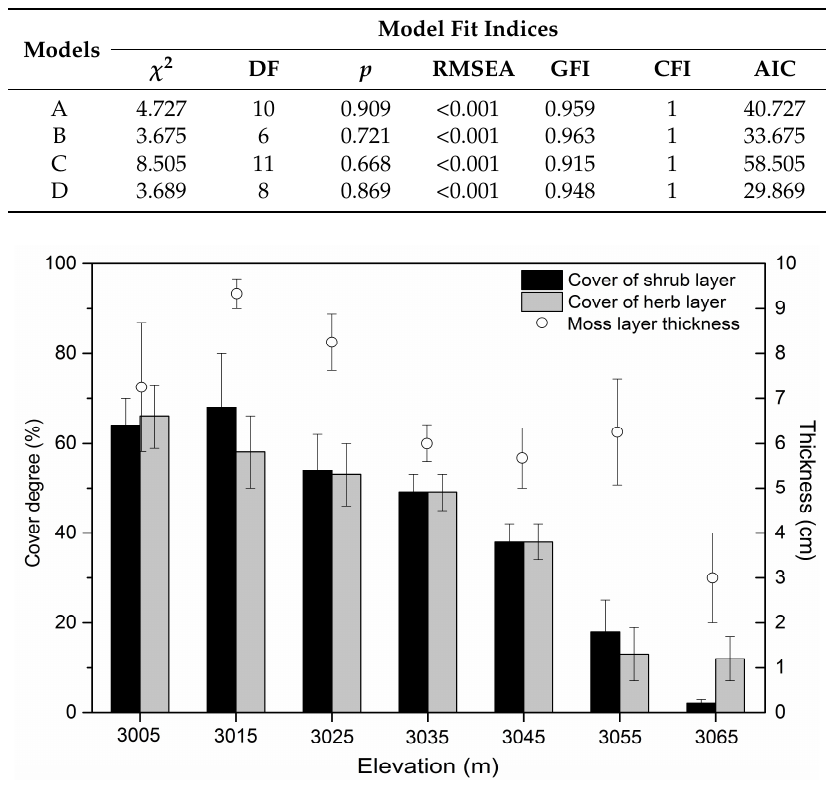
Figure 5. Data of biotic factors (shrub layer cover, herb layer cover, and moss layer thickness) in gaps for the study area in a subalpine coniferous forest along elevation (3000–3700 m). Error bars represent standard error.